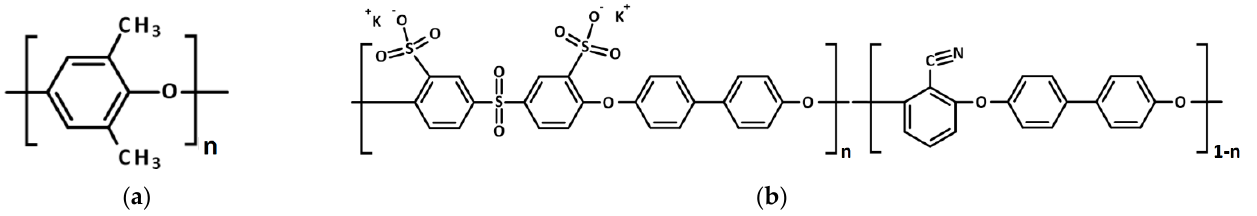
Figure 2. Chemical structures of ( a ) polyphenylene oxide (PPO) and ( b ) sulfonated poly(arylene ether sulfone nitrile) (SPN-20). The hollow-fiber support was made of PPO and the separation layer of SPN-20 was formed on the outer surface of a PPO hollow-fiber membrane. Details are described in Ohkame et al. [22].